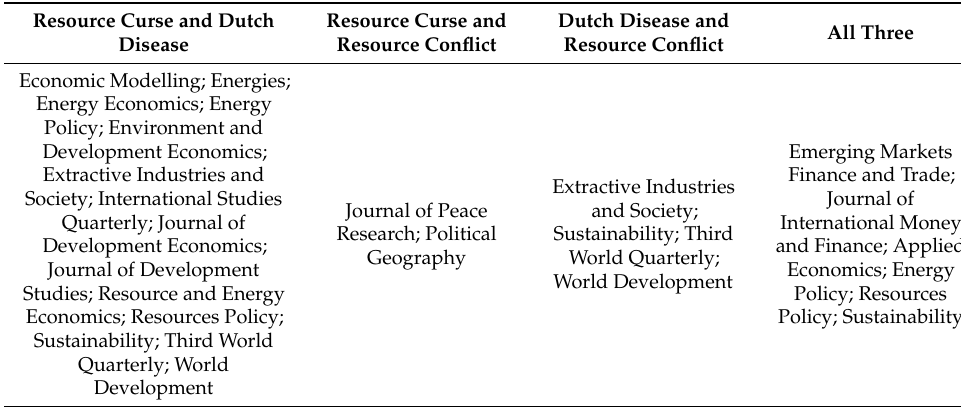
Figure A3. Network of prominent journals on resource conflict. Table A1. Mainstream journals converging in the three strings of literature.